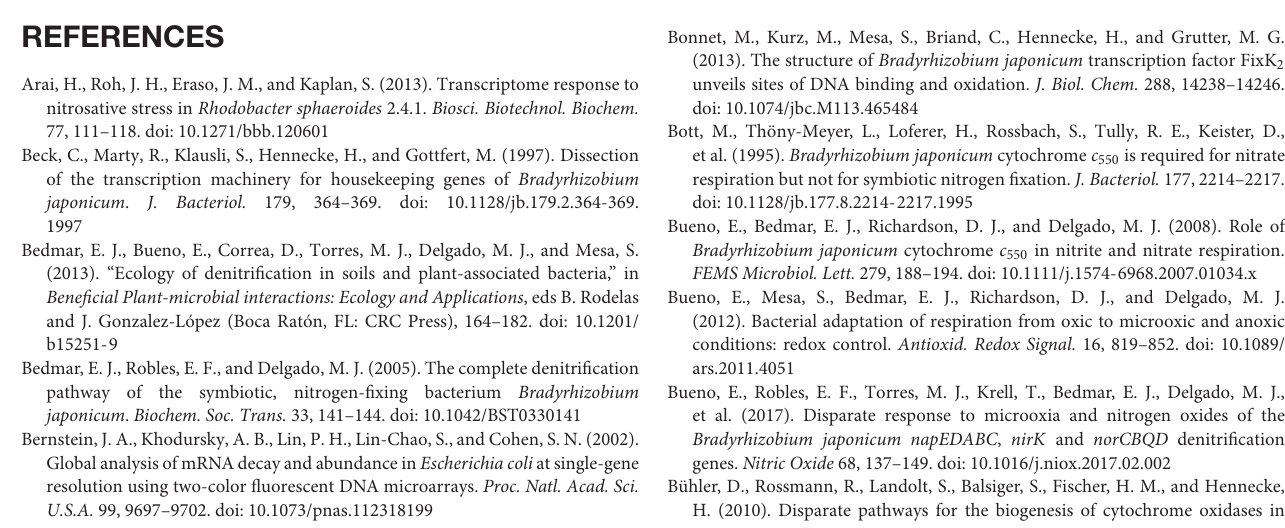
FIGURE S1 | Nitrous oxide reductase (N 2 OR) activity in the absence and in the presence of succinate as electron donor determined in the WT and cy 2 , and cycS